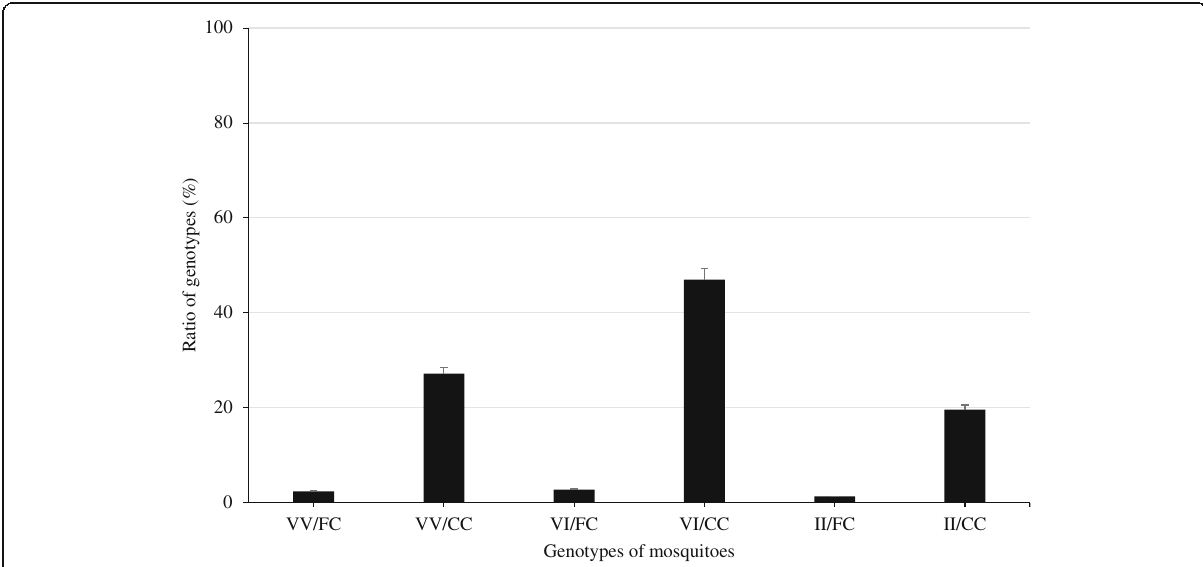
Fig. 2 Frequency of the combined V1016I and F1534C genotypes where VV/FC, VV/CC, VI/FC, VI/CC, II/FC and II/CC mean respectively and 1016VV/1534CC, 1016VV/1534CC, 1016VI/1534FC, 1016VI/1534CC, 1016II/1534FC and 1016II/1534CC genotypes